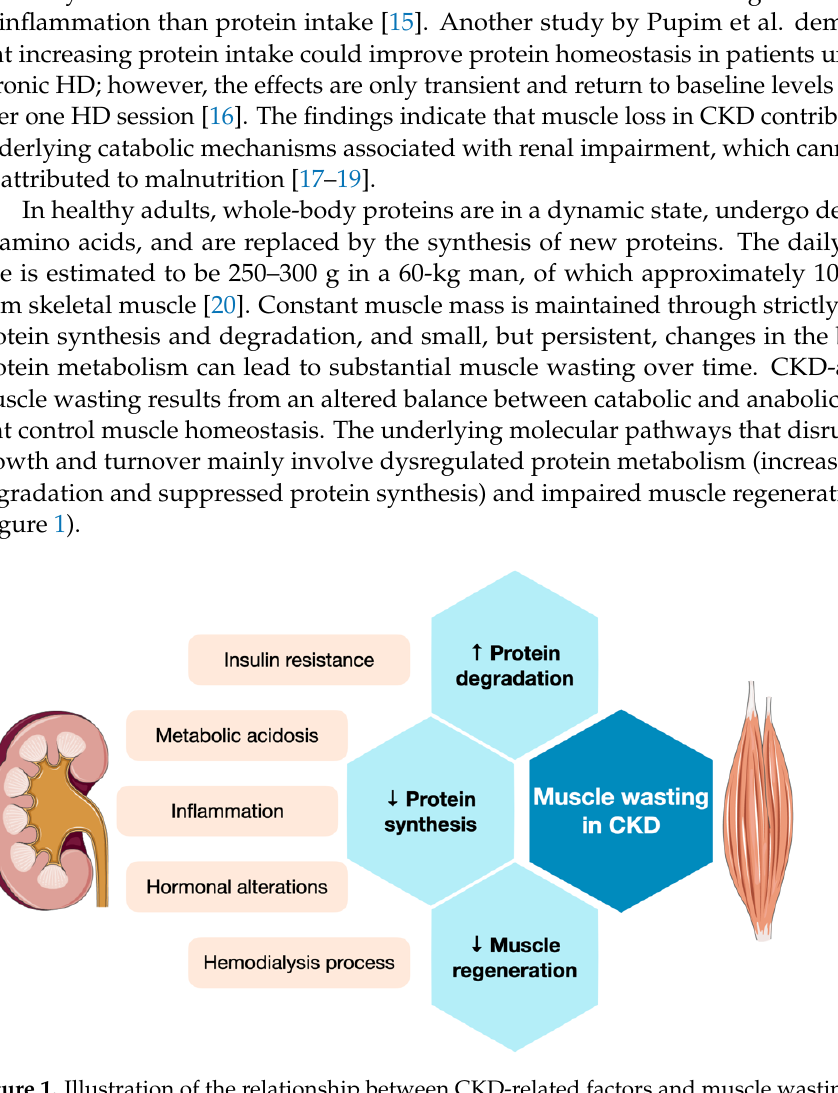
Figure 1. Illustration of the relationship between CKD-related factors and muscle wasting. Upward arrows indicate increase or activation; downward arrows indicate decrease or suppression. The graphics used in this figure are adapted from Sevier Medical Art (www.smart.servier.com, accessed on 5 April 2022).